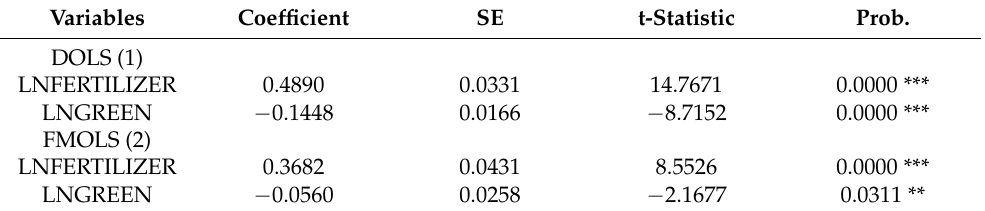
Table 8. Benchmark results.